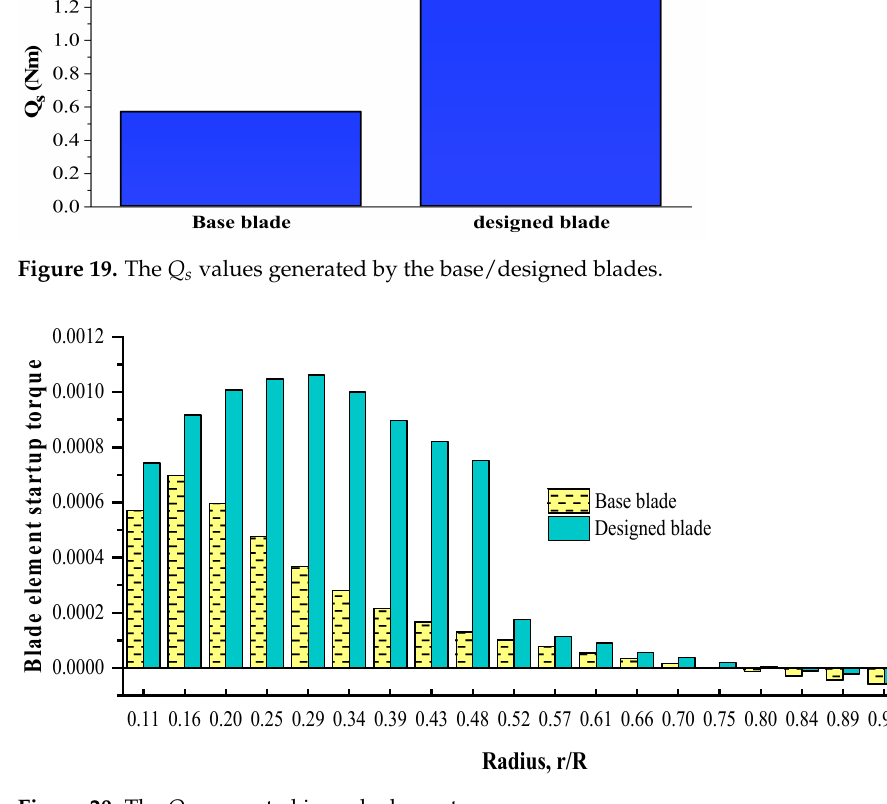
Figure 20. The Q s generated in each element.